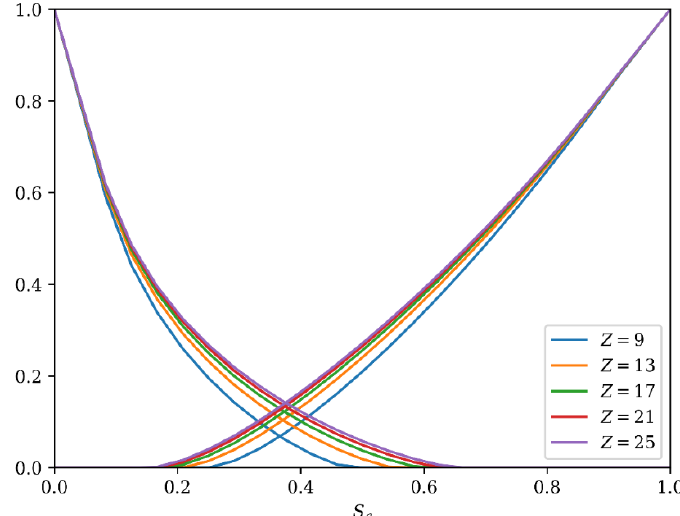
Figure 10. The sensitivity of the two-phase gas-oil relative permeabilities to changes in coordination number Z , for fixed f g = 0.4, f o = 0.2.